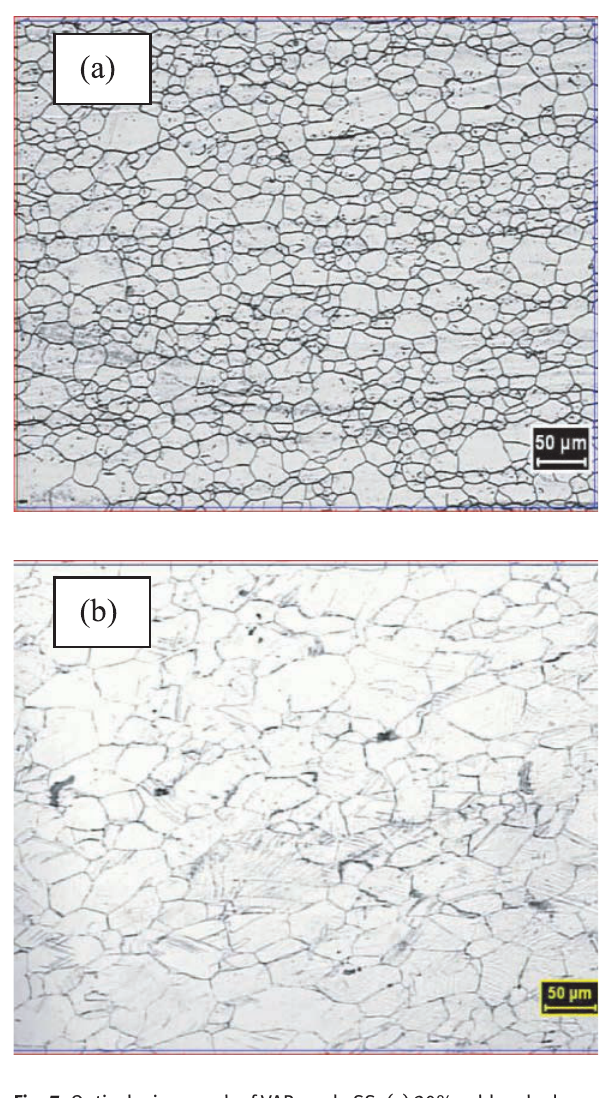
Fig. 7: Optical micrograph of VAR grade SS; (a) 20% coldworked condition and (b) after tensile testing at 1023